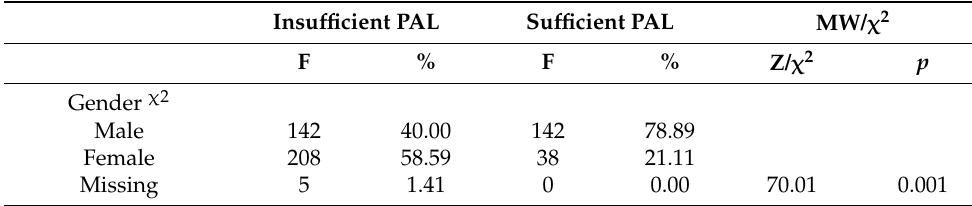
Table 1. Descriptive statistics (F—frequencies; %—percentages) for the study variables, with differ- ences between groups according to the insufficiency/sufficiency of the physical activity levels (PAL) at the baseline (MW—Mann–Whitney test; χ 2 —Chi square